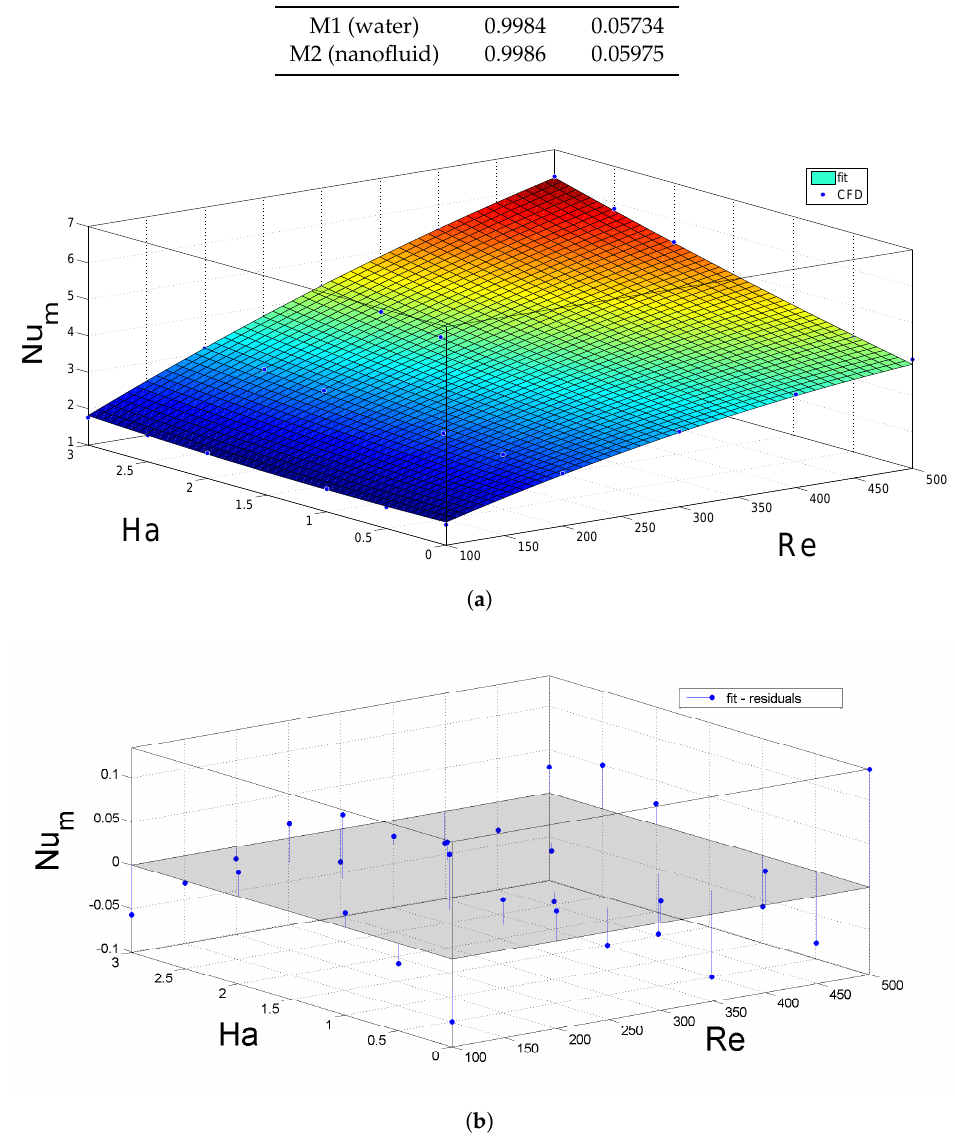
Figure 8. Surface fit with polynomials (average Nusselt number for the hot walls) and residuals with respect to changes in Reynolds and Hartmann number: ( a ) polynomial fit to the CFD data; and ( b ) residuals between the polynomial fit and CFD